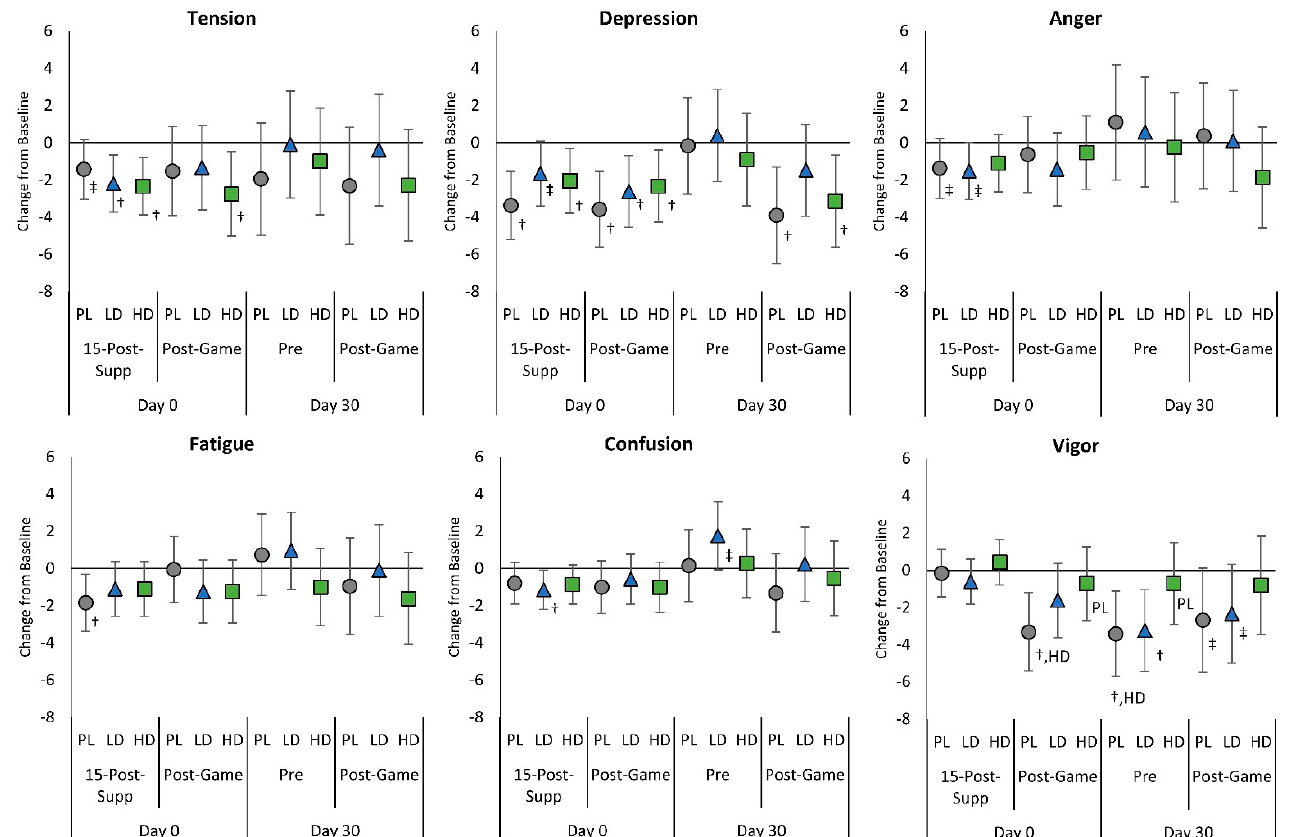
Figure 10. Profile of Mood State domain changes from baseline with 95% confidence intervals from Day 0, pre-game (Pre) values for the placebo (PL), low-dose (LD), and high-dose (HD) groups. † represents p < 0.05 from Pre values while ‡ represents p > 0.05 to p < 0.10 effect. 15-min-Post-Supp represents data obtained 15-min after supplementation and Post-Game represents data obtained after competitively playing video games for 60 min. Group differences ( p < 0.05) are shown as differences from placebo (pl), low-dose (ld), and high-dose (hd) groups, while statistical tendencies ( p > 0.05 to p < 0.10) are shown in large case (PL, LD, HD).